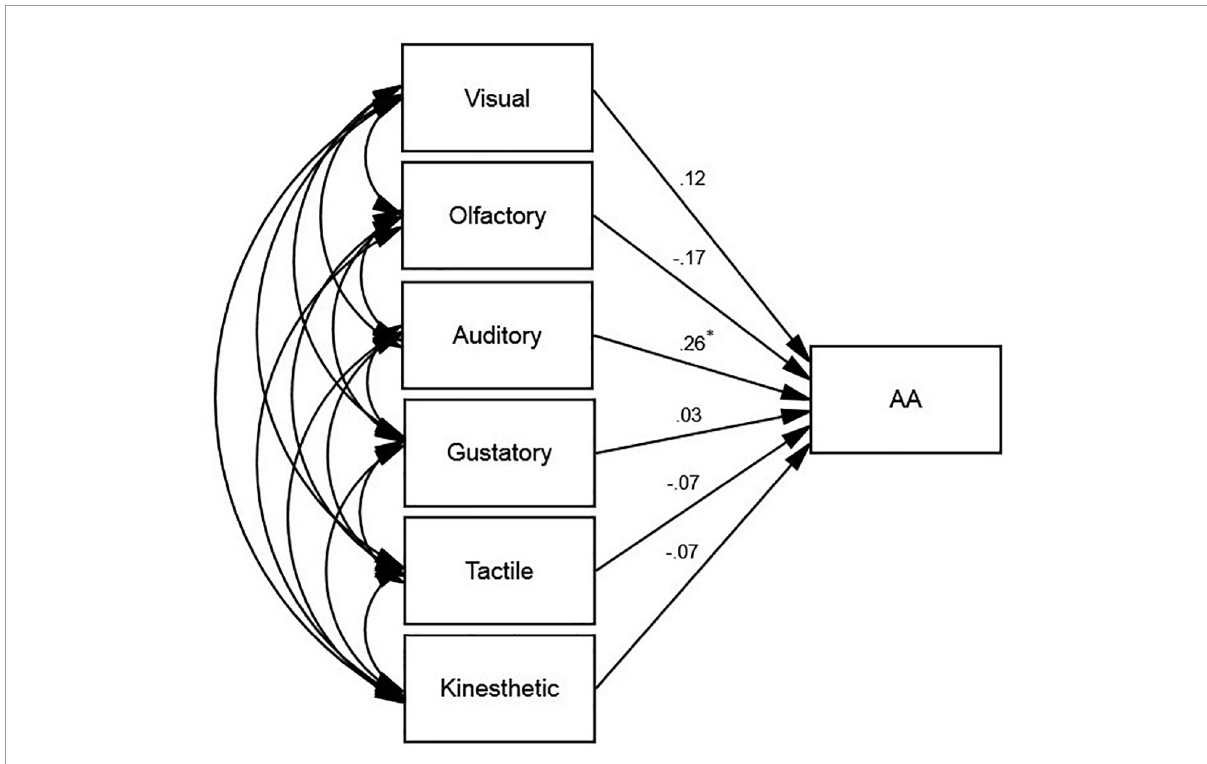
FIGURE4 The schematic representation of the relationships between Academic Achievement (AA) and the subconstructs of ESQ, namely visual, olfactory, auditory, gustatory, tactile, and kinesthetic ( ∗ p < 0.05).